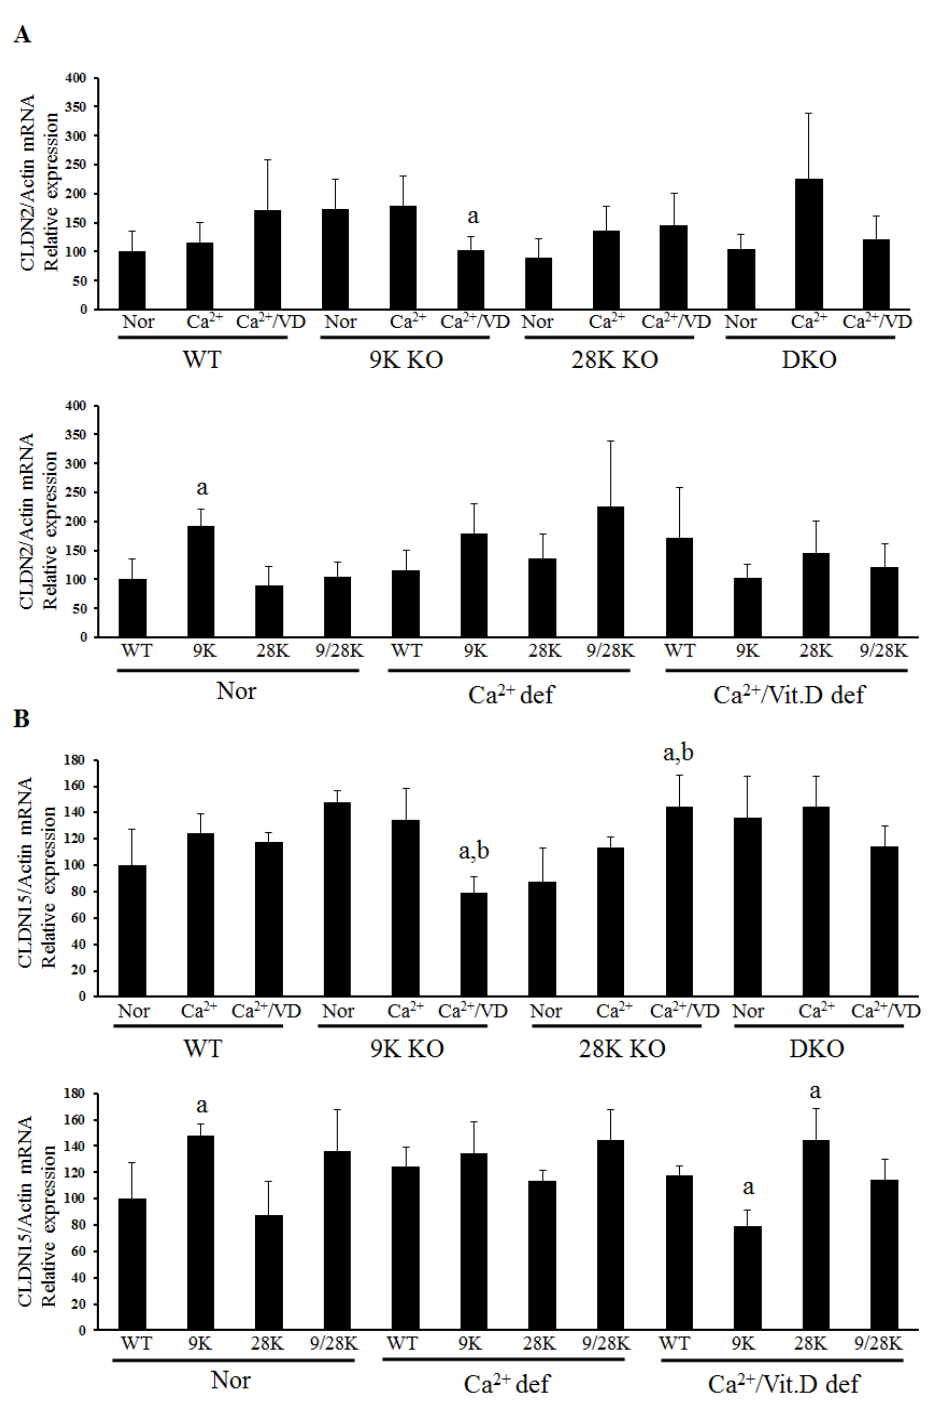
Figure 1. Tissue-specific tight junction genes expression in the duodenum of mice. CLDN2 ( A ) and CLDN15 ( B ) mRNA expression were analyzed by real-time PCR. The expressions of each gene were compared through the type of animal ( upper panel ) and diets ( lower panel ). Every result was normalized relative to β-actin. In upper panel of (A) and (B) , Nor, normal diet; Ca 2+ , calcium-deficient group; Ca 2+ /VD, calcium- and vitamin D-deficient diet; a, p < 0.05 ( vs. normal diet) and b, p < 0.05 ( vs. calcium deficient diet). In lower panel of (A) and (B) , WT, wild-type; def, deficient diet; 9k, CaBP-9k KO mice; 28k, CaBP-28k KO mice; 9k/28k, DKO mice; a, p < 0.05 ( vs. wild-type